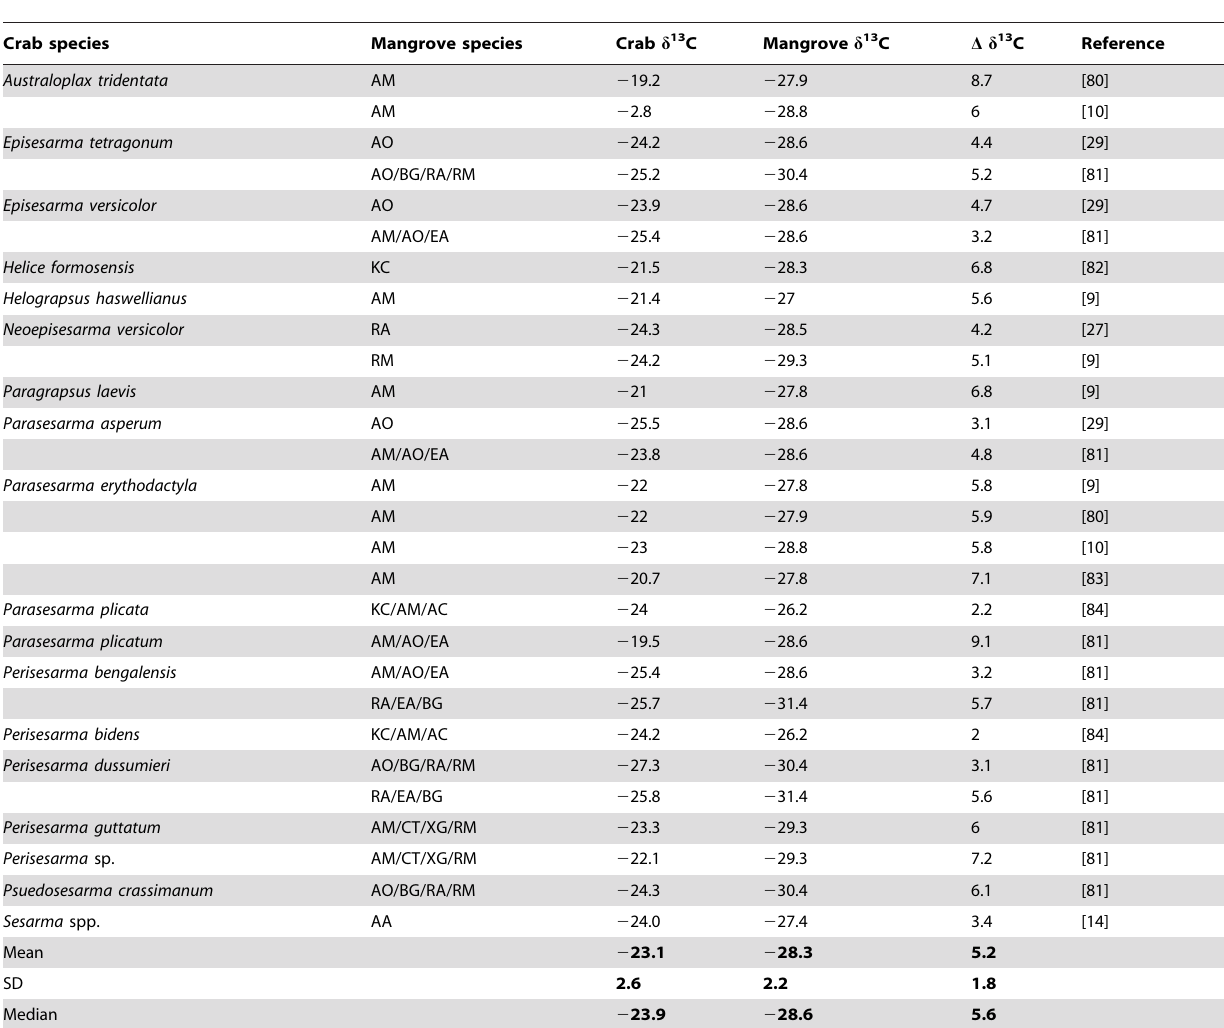
Table 2. Difference in d 13 C values of the mangrove grapsid and their associated mangrove leaf litter from the literature.